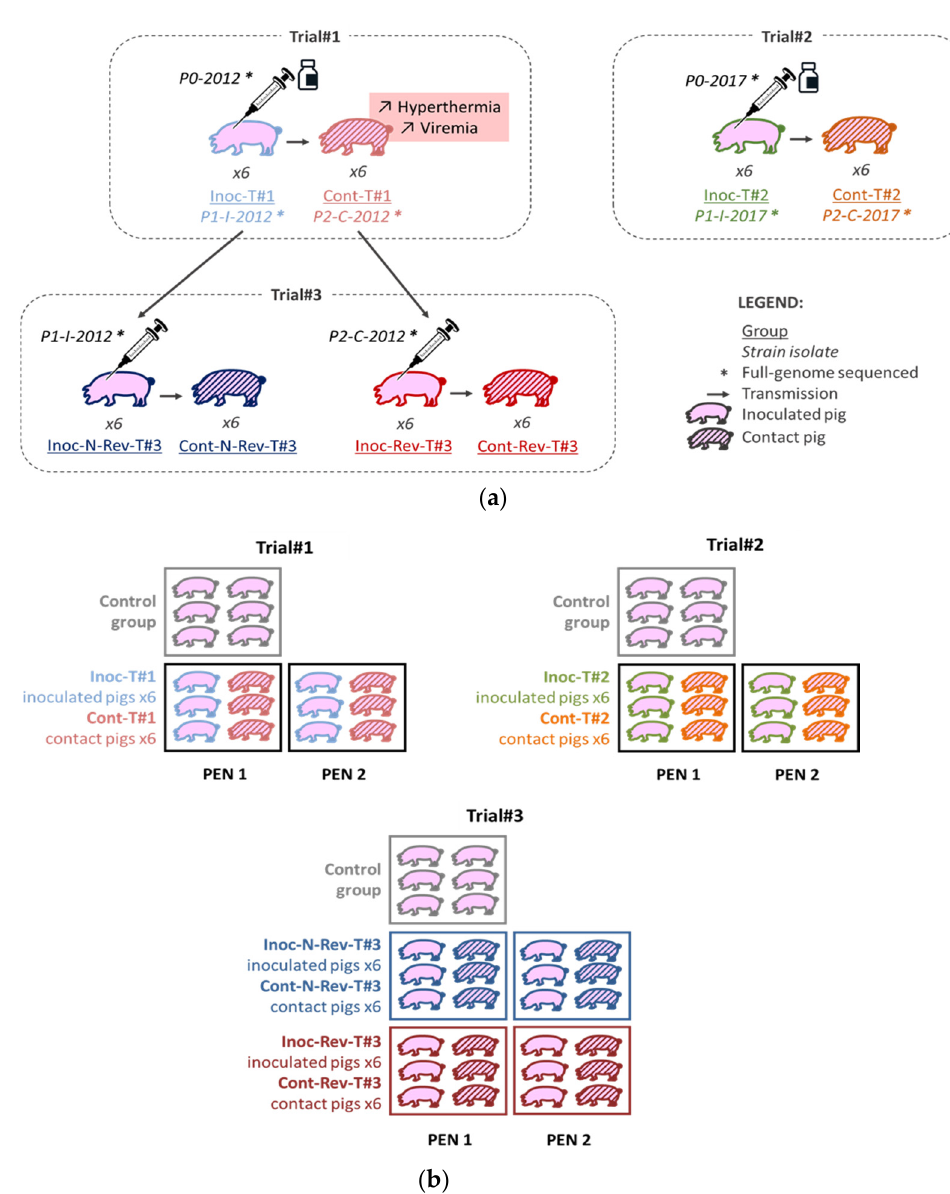
Figure 1. Global framework ( a ) and schemes ( b ) of the three different animal experiments. Table 1. Experiment parameters for Trial#1, Trial#2 and Trial#3.